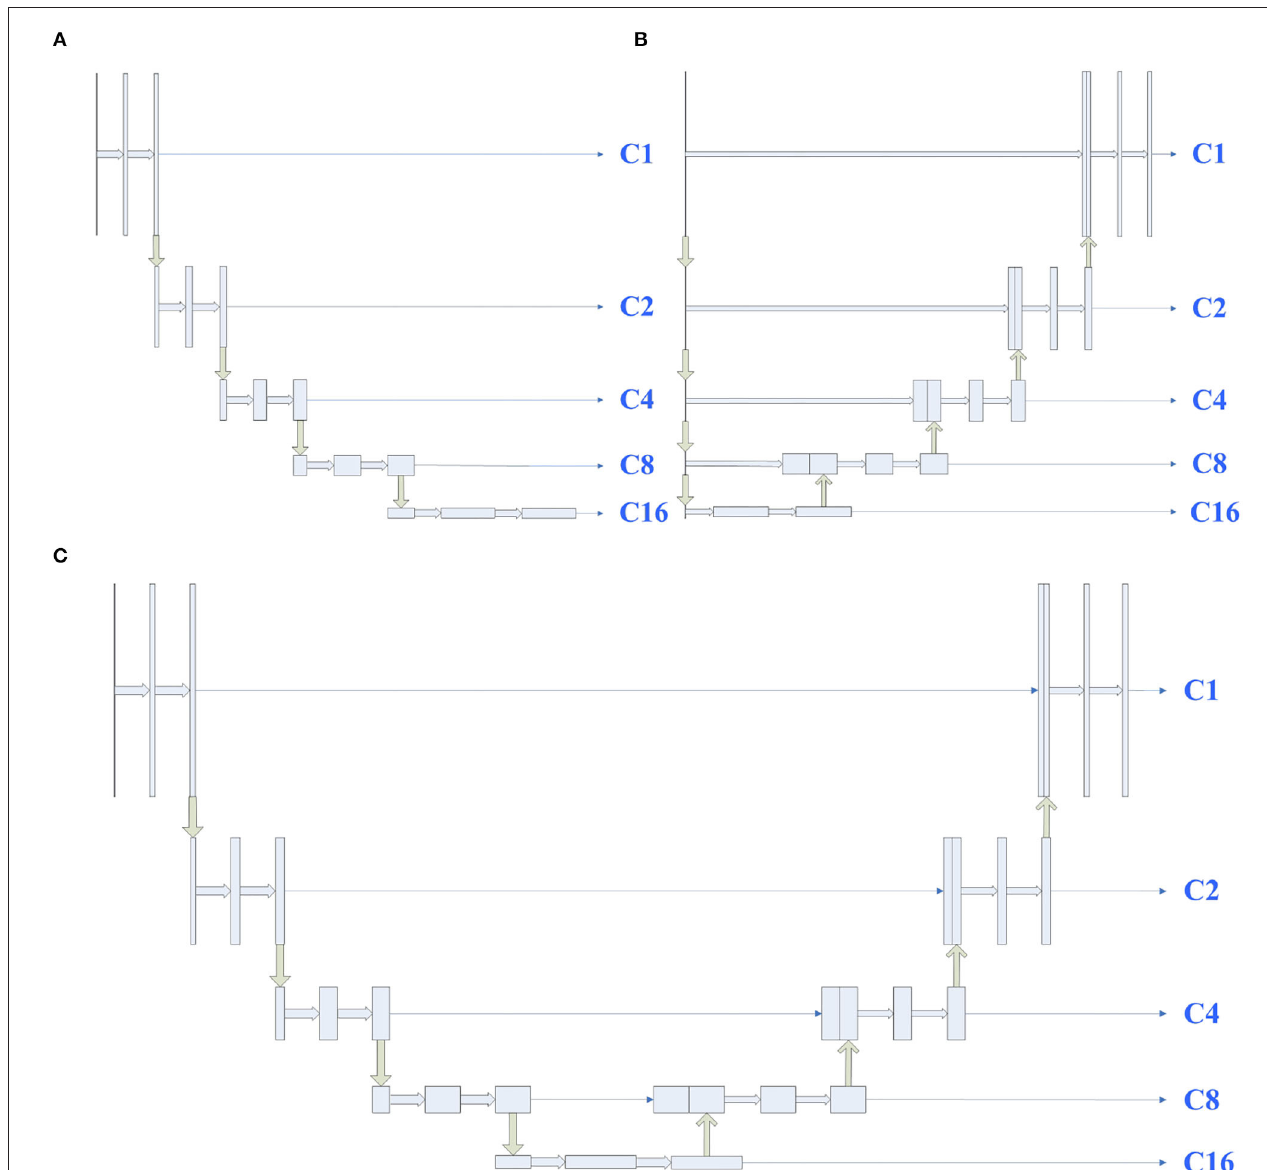
FIGURE 1 | Illustrations of different types of encoders, the structures of encoders (A–C) are derived from UNet’s encoder, decoder, and full structure, respectively. C1 represents a feature map of the same size as the input map, and C2, C4, C8, and C16 denote output features of the encoder with a downsample rate of {2, 4, 8, 16}. The yellow down (up) arrow represents downsampling (upsampling), and the right thick (thin) arrow represents convolution